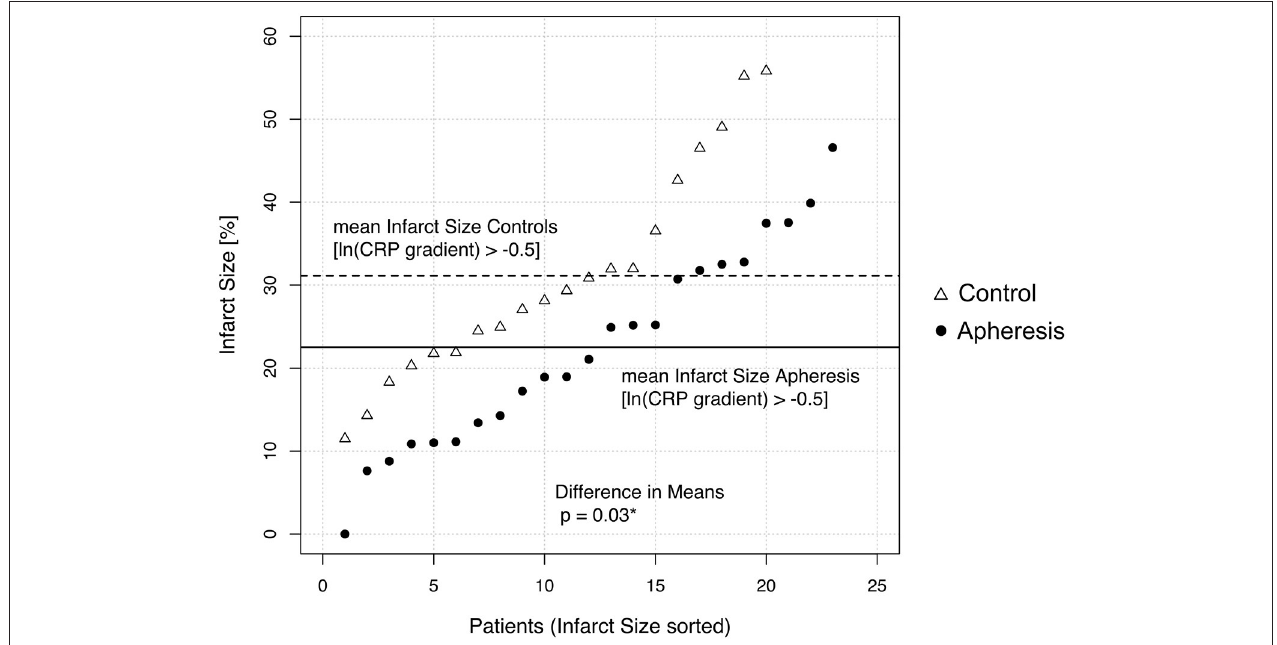
FIGURE 4 | Difference of the Infarct Size at CMR1 between control and apheresis patients with high CRP gradient. Only patients with a CRP gradient higher than 0.6 ( > ln(gradient) − 0.5) were analyzed and sorted according to their infarct size. Mean Infarct sizes are indicated with dotted (control) or black (apheresis) line. Means differ significantly ( p = 0.03 after Student’s t